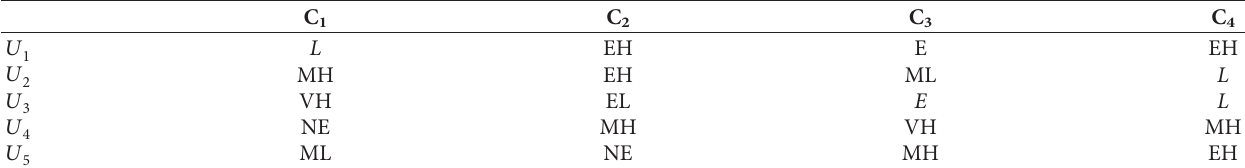
Table 4: The evaluated linguistic values of decision maker DM